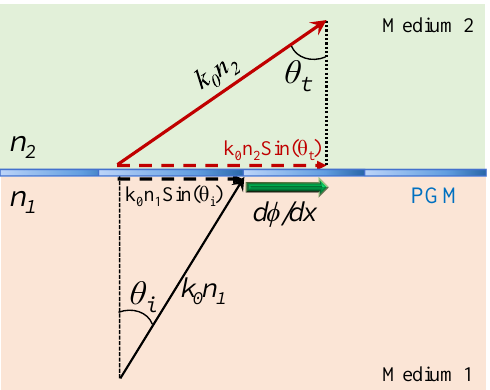
Figure 2. Generalized Snell’s law (A 2D situation where the phase gradient lies along the plane of incidence). PGM referes to phase-gradient